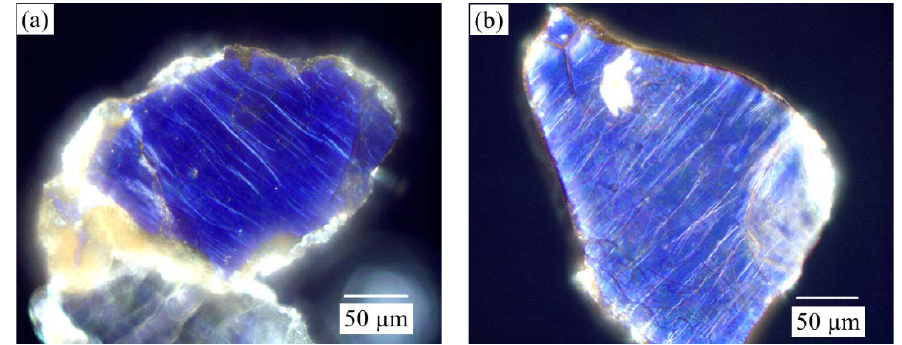
Figure 4. Polarizing luminescence of muscovite at transmitted, crossed, and polarized light: ( a ) muscovite within calcinated quartz sand (900 °C for 5 h); and ( b ) muscovite within leached quartz sand (0.100 mol/L H 2 SO 4 , 0.200 mol/L NH 4 Cl, 5 mL/g of L/S ratio, 200 °C).